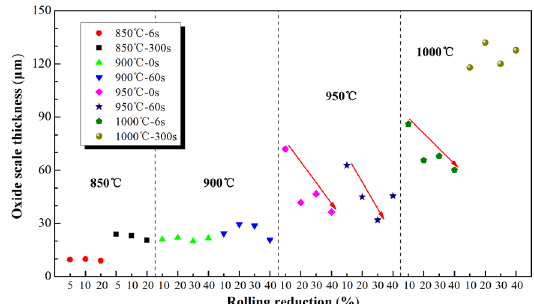
Figure 5. The relationship of the thickness of oxide scale and rolling conditions.